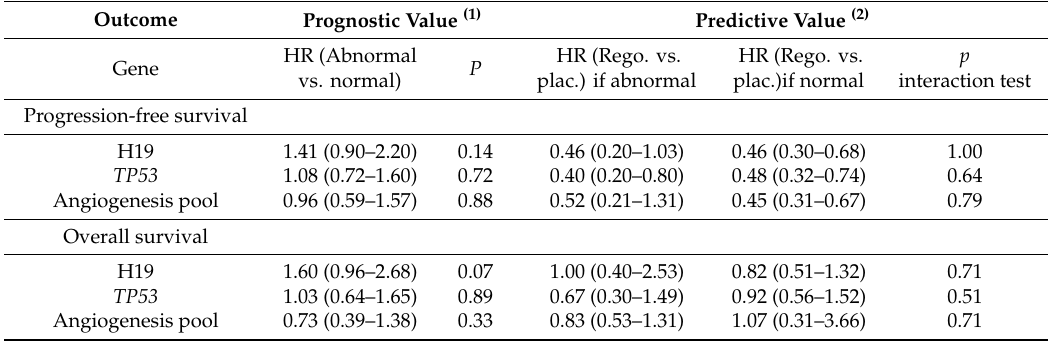
Table 3. Evaluation of the prognostic and predictive values of H19 positivity, TP53 mutation, and mutation in angiogenesis pool, in terms of PFS and OS.